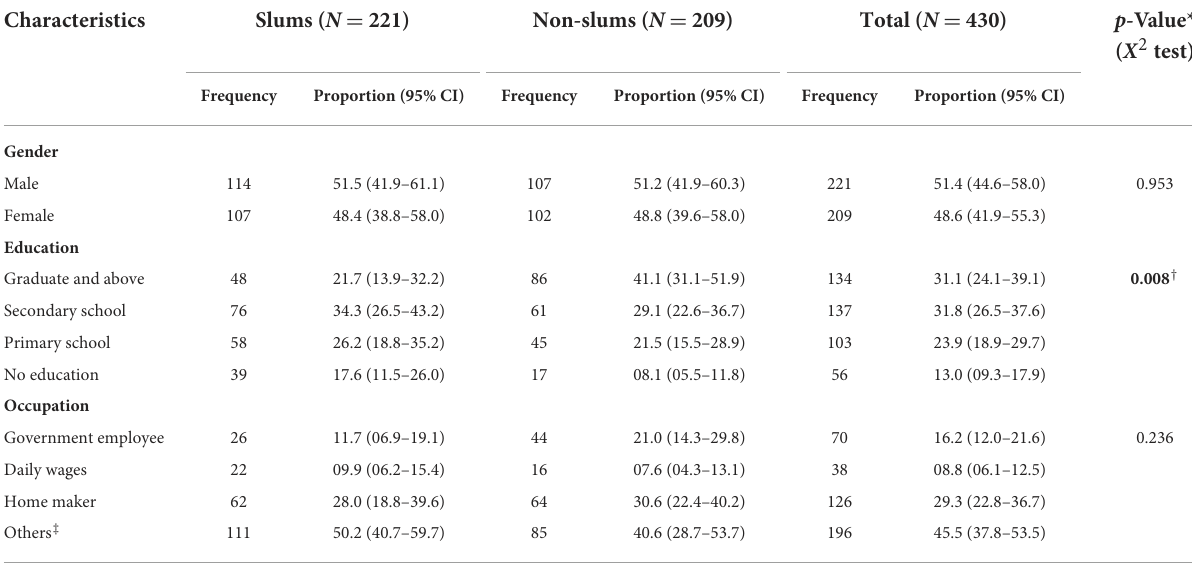
TABLE 1 Sociodemographic profile of the study participants, Greater Chennai Corporation, India, March 2021 ( N = 430).